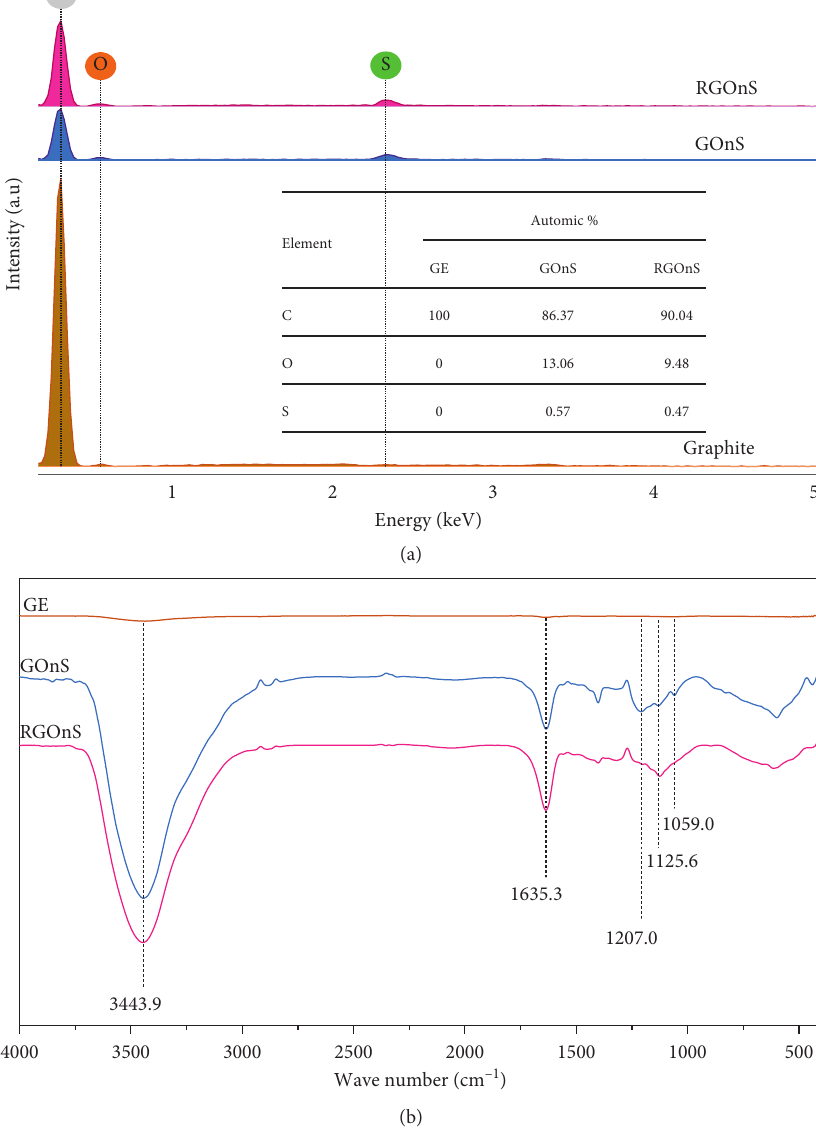
Figure 2: EDX (a) and FTIR (b) spectra of graphite, graphite oxide nanosheet electrode (GOnS), and reduced graphite oxide nanosheet electrode